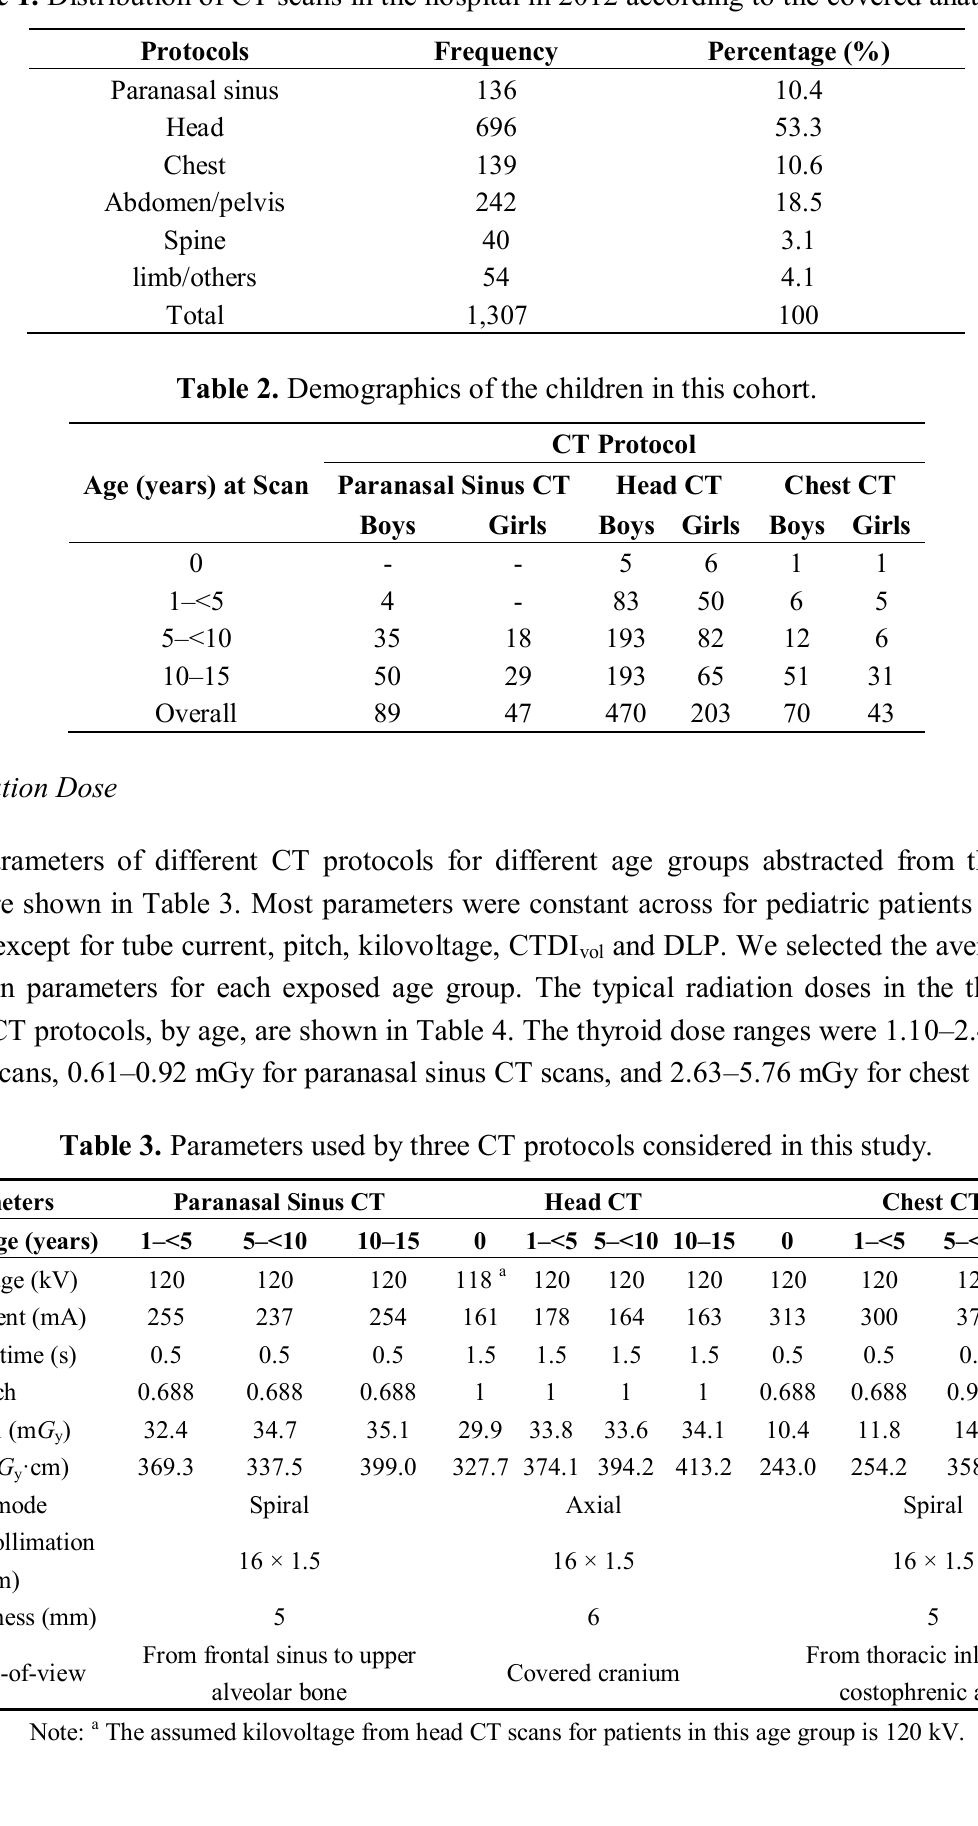
Table 1. Distribution of CT scans in the hospital in 2012 according to the covered anatomies.